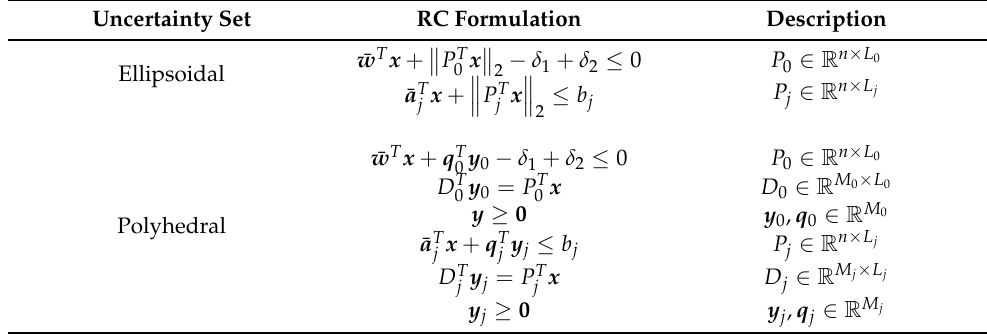
Table 2. RC formulation for problem (19). Uncertainty